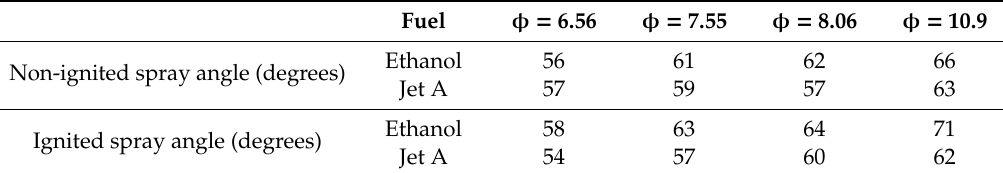
Figure 8. Mie scattering images of Jet A spray at four equivalence ratios. The O 2 flow rate was fixed at 0.4 L/min. Table 1. Mie Scattering Spray Cone Angles.